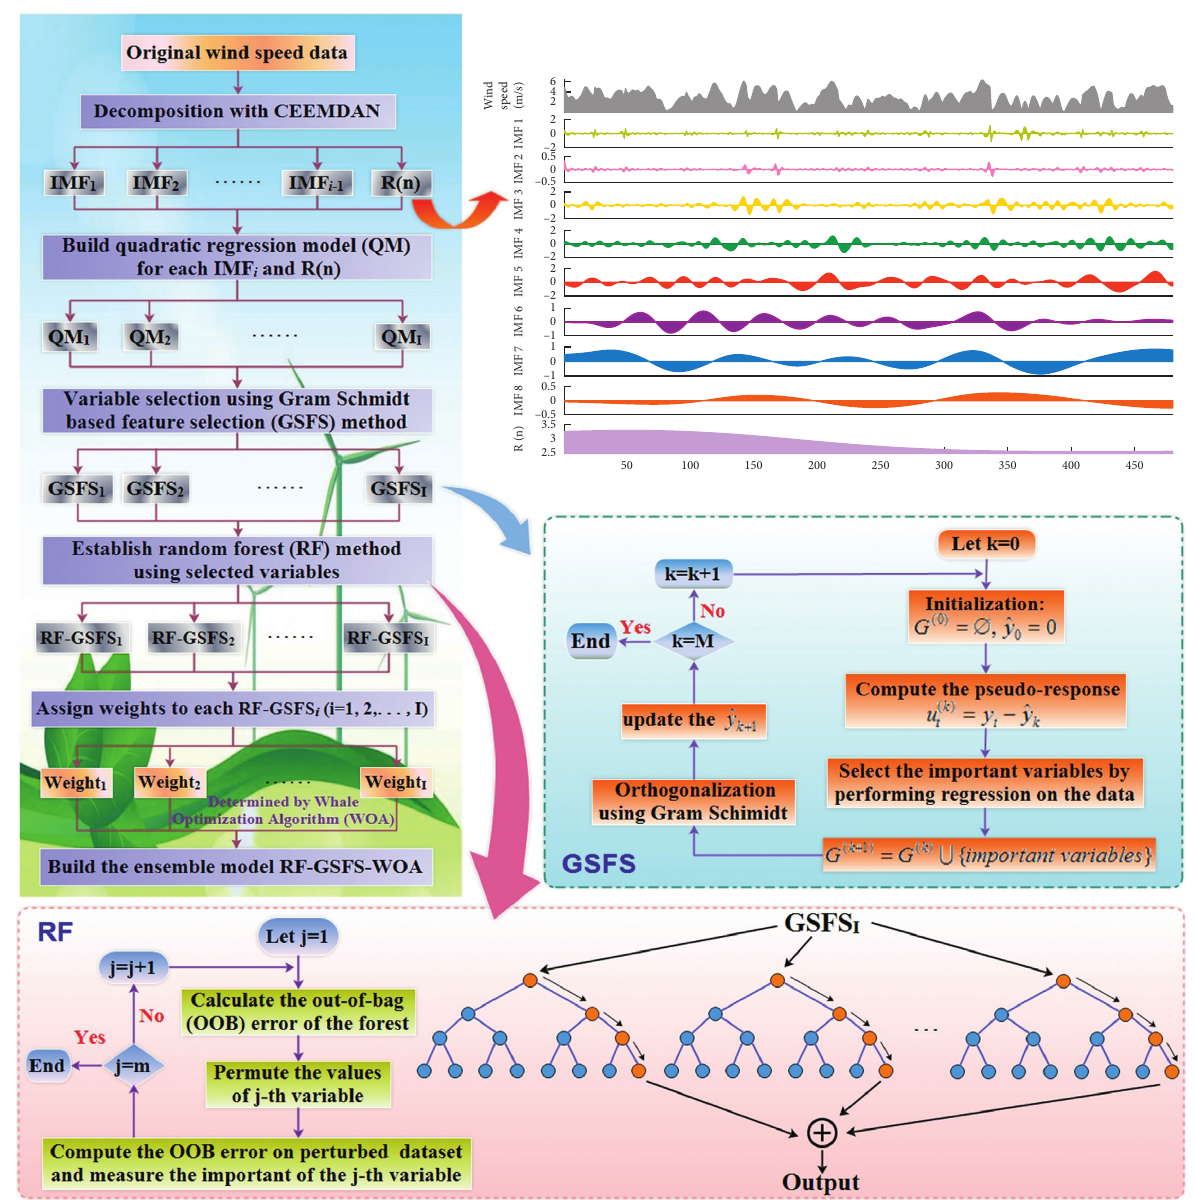
Figure 3: Flowchart of the developed model: